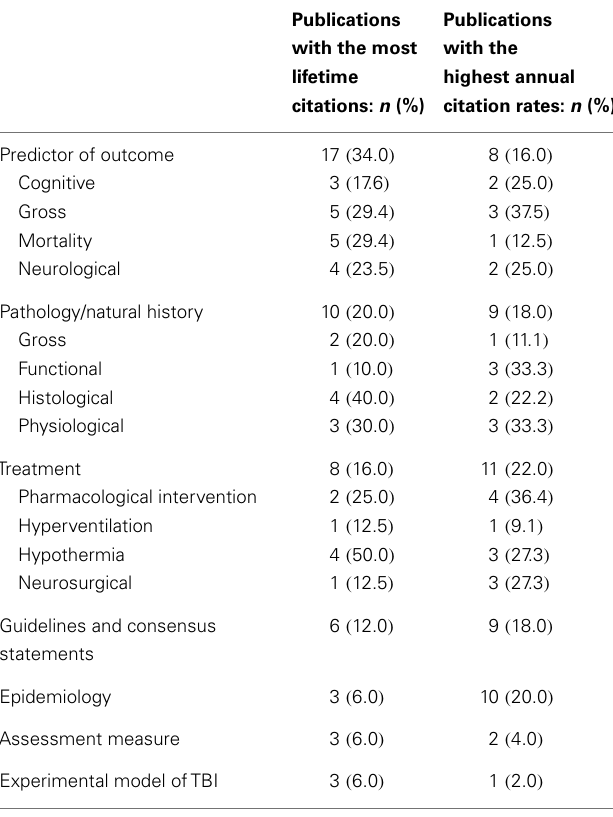
Table 4 | Categorical dissection of publications in both citation cohorts